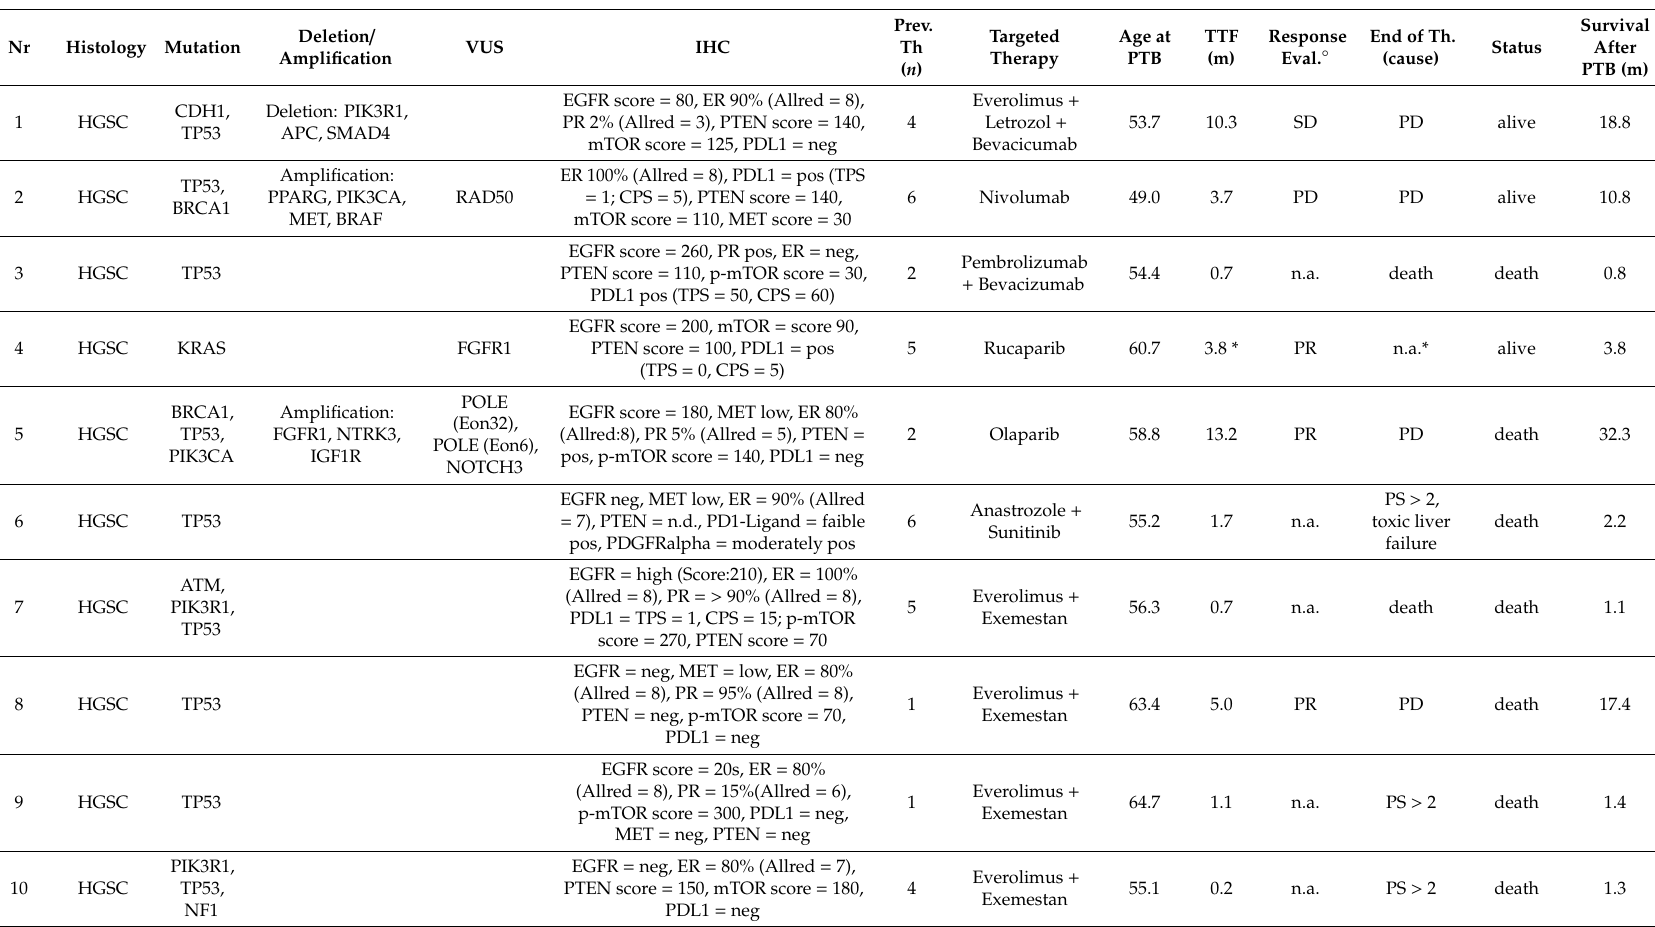
Table 3. Characteristics of the 12 patients receiving a targeted treatment based on the precision medicine tumor board (PTB)